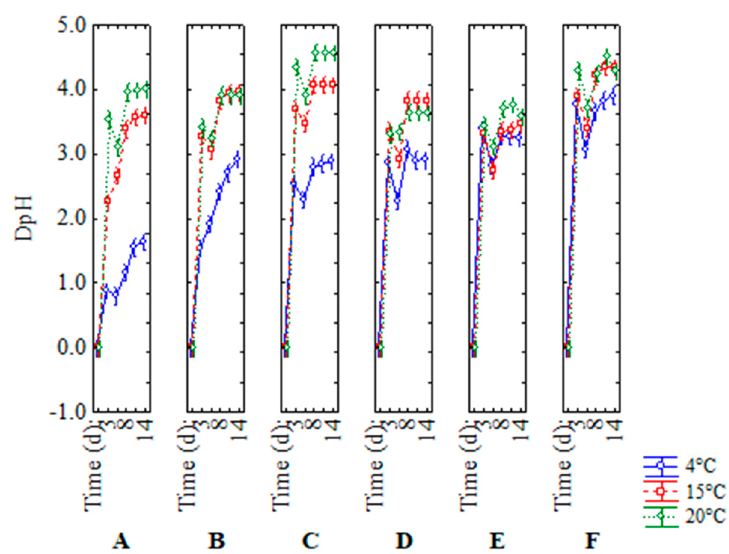
Figure 8. Decomposition of the statistical hypothesis for the interaction temperature–time–treatment on acidification. Bars denote 95% confidence intervals. Experiment on the effect of a thermal abuse in rice beverage for L. plantarum c16 and c19. For the code of US treatments see Table 2.